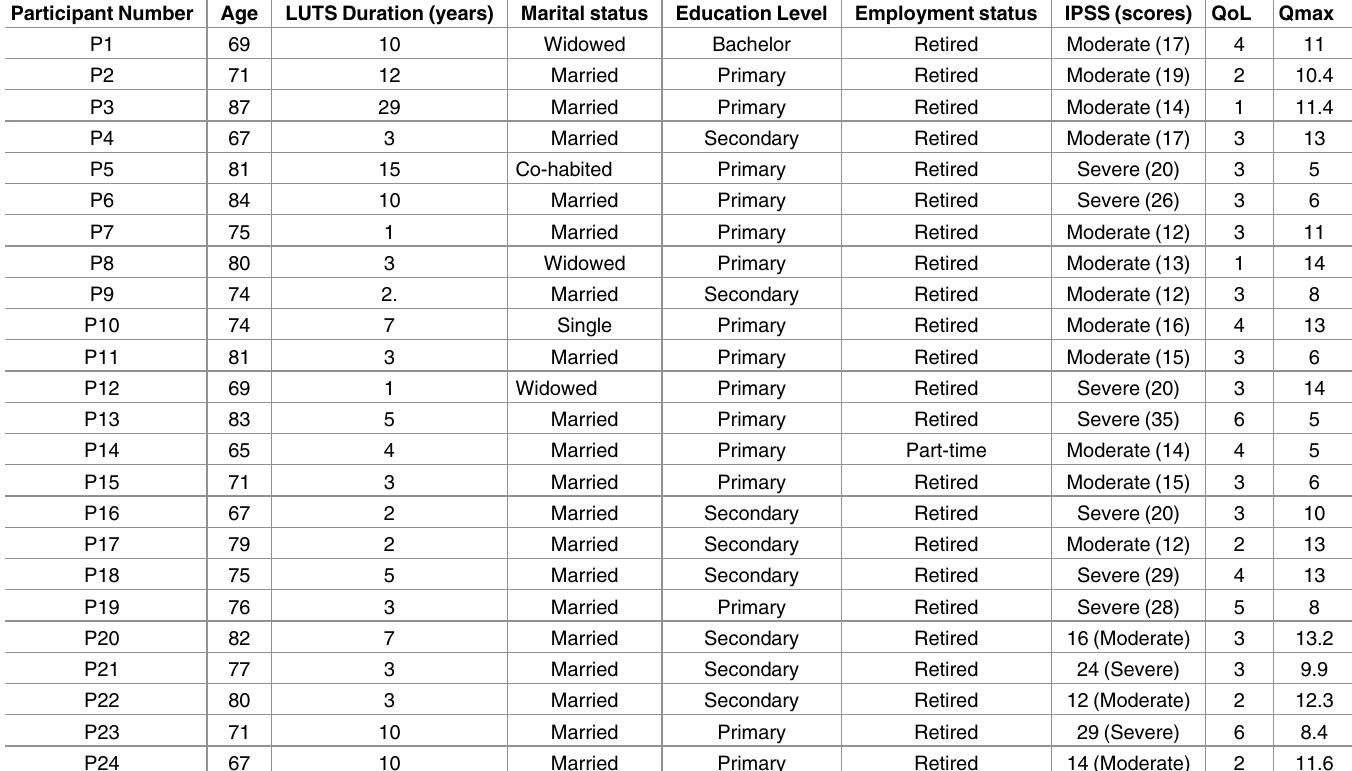
Table 2. Summaryof the demographic characteristics of the